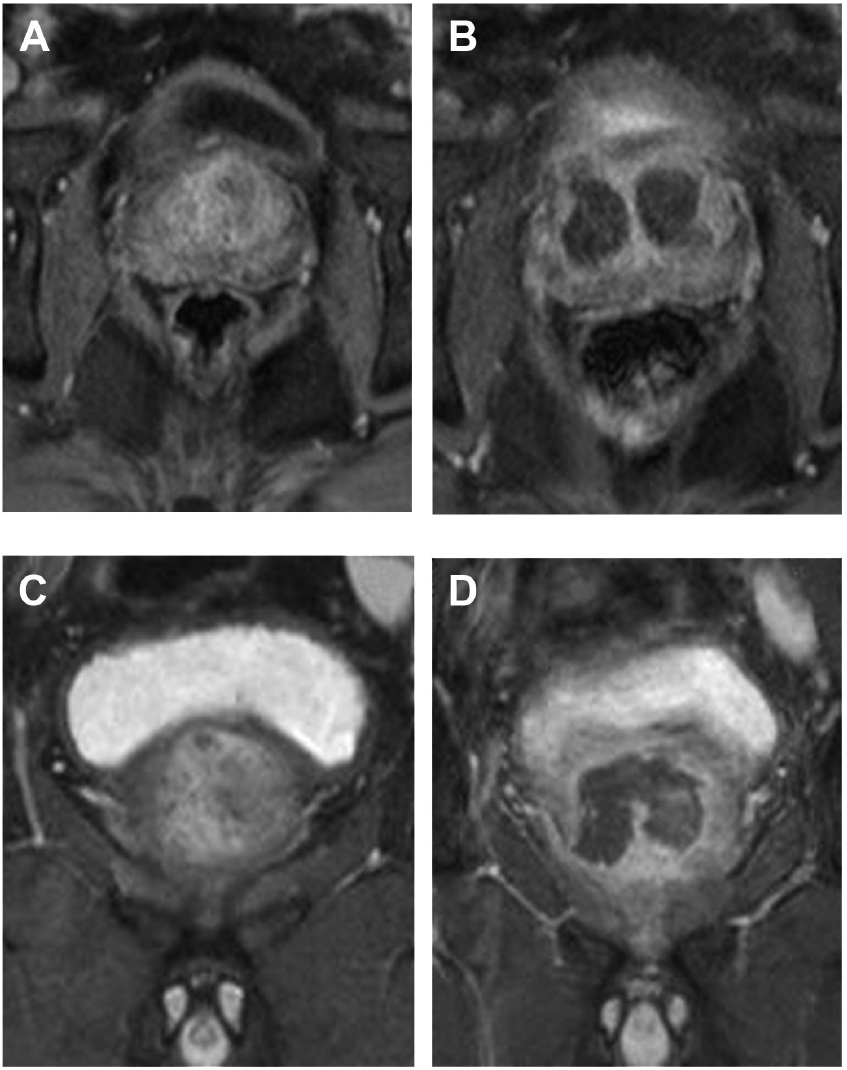
FIGURE 1. Pre- (A, C) and post-treatment (B, D) axial (A, B) and coronal (C, D) MRIs of bladder neck and lateral